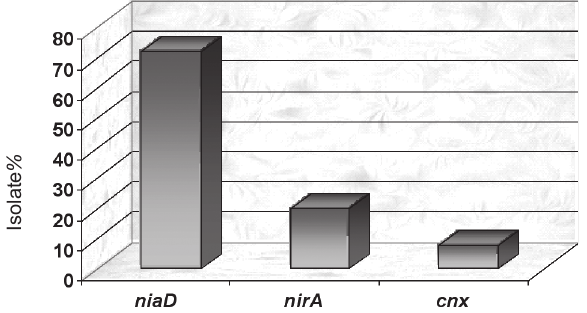
Fig. 1. Aspergillus fl avus nit mutant